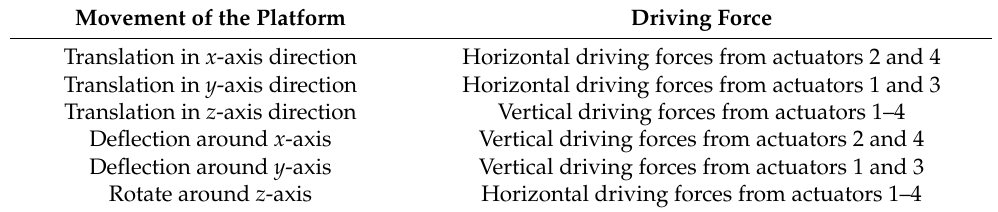
Figure 3. Structure and working principle of the magnetic suspension platform.